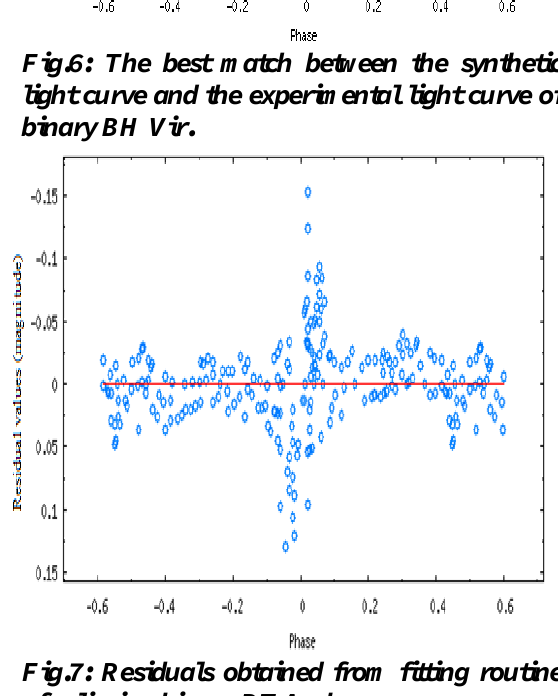
Fig.7: Residuals obtained from fitting routine of eclipsing binary RT And.